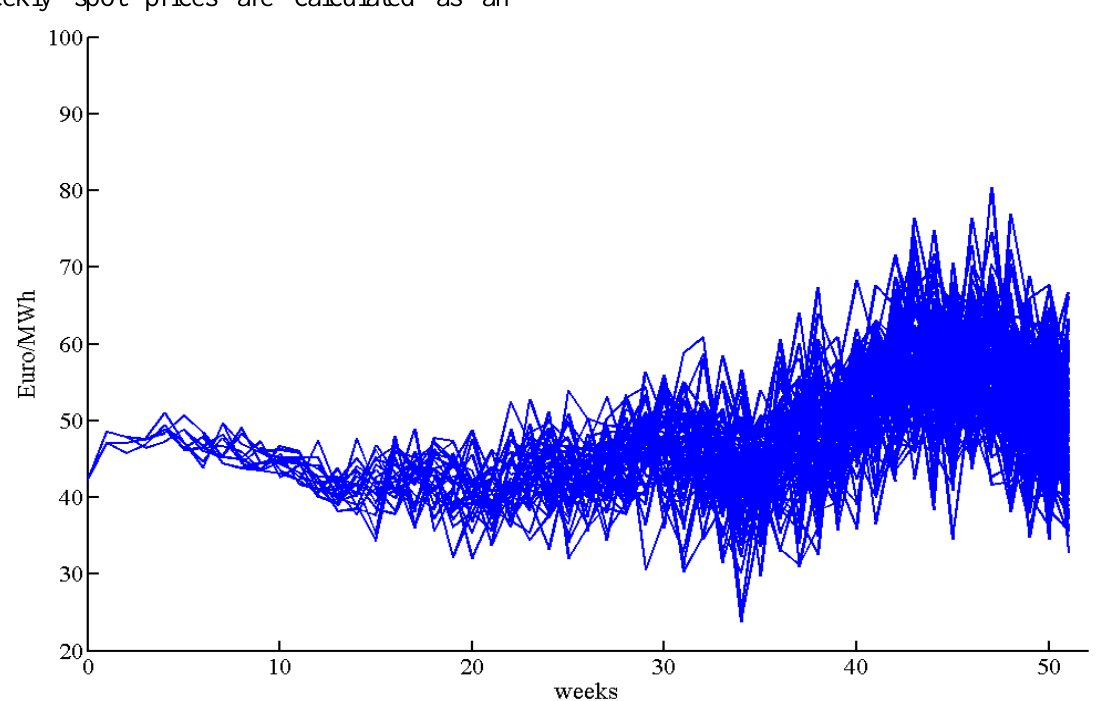
Fig. 5. Scenario tree of electricity spot